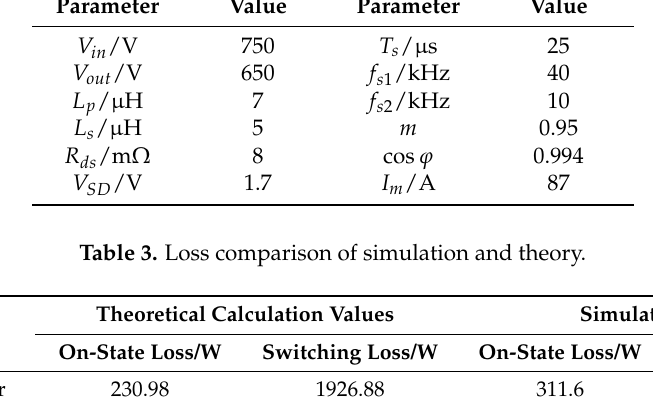
Table 2. The parameters of theoretical calculation.